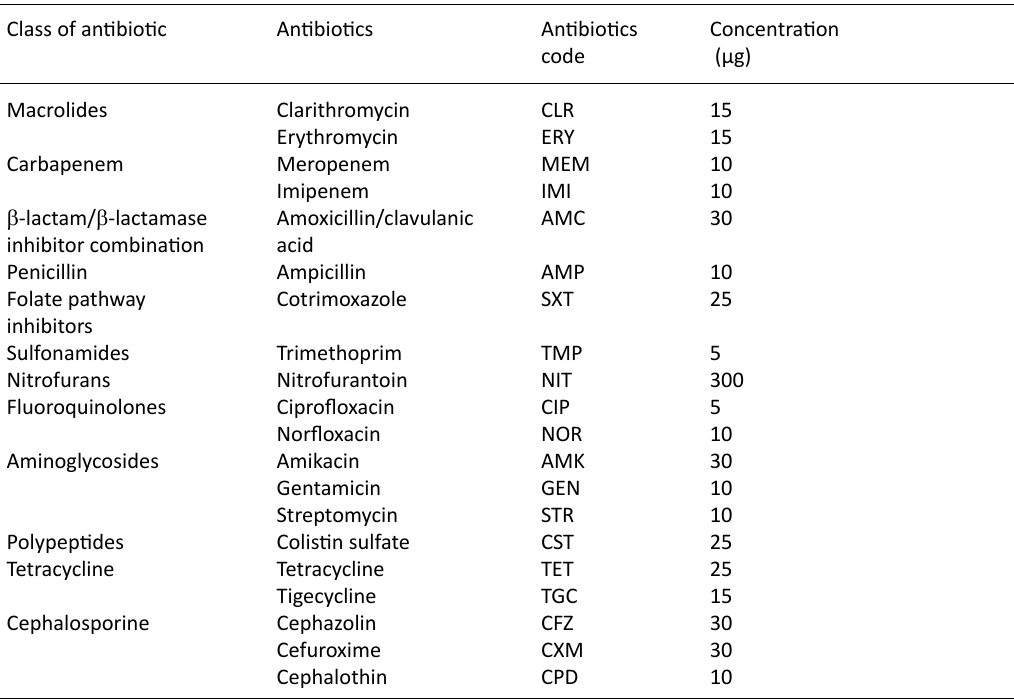
Table 1. Antibiotics used for E. coli susceptibility profile